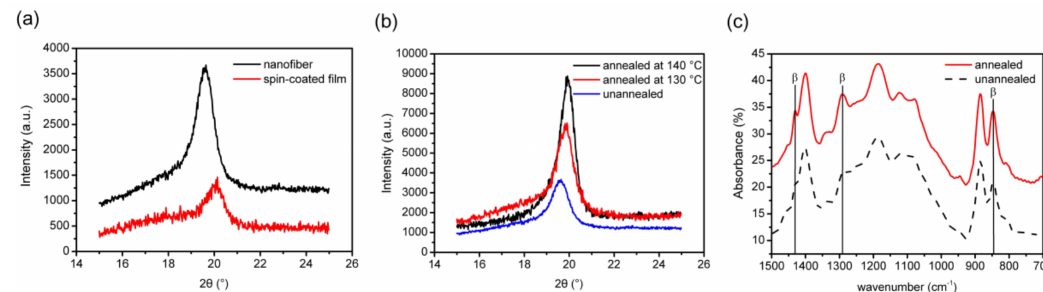
Figure 2. Characterization of the P(VDF-TrFE) nanofibers. ( a ) X-ray diffraction (XRD) patterns of the spin-coated P(VDF-TrFE) film and electrospun P(VDF-TrFE) nanofibers. ( b ) XRD patterns of the P(VDF-TrFE) nanofibers before and after annealing at 130 and 140 ◦ C for 2 h. ( c ) Fourier transform infrared (FTIR) spectra of the P(VDF-TrFE) nanofibers before and after annealing at 140 ◦ C for 2